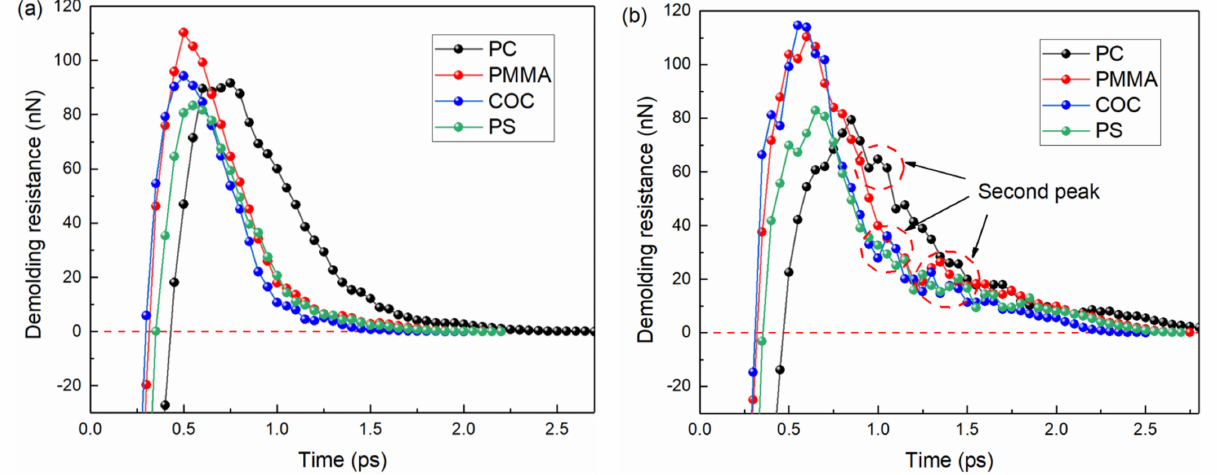
Figure 10. The demolding resistance of PC, PMMA, COC and PS in demolding: ( a ) channel structures,